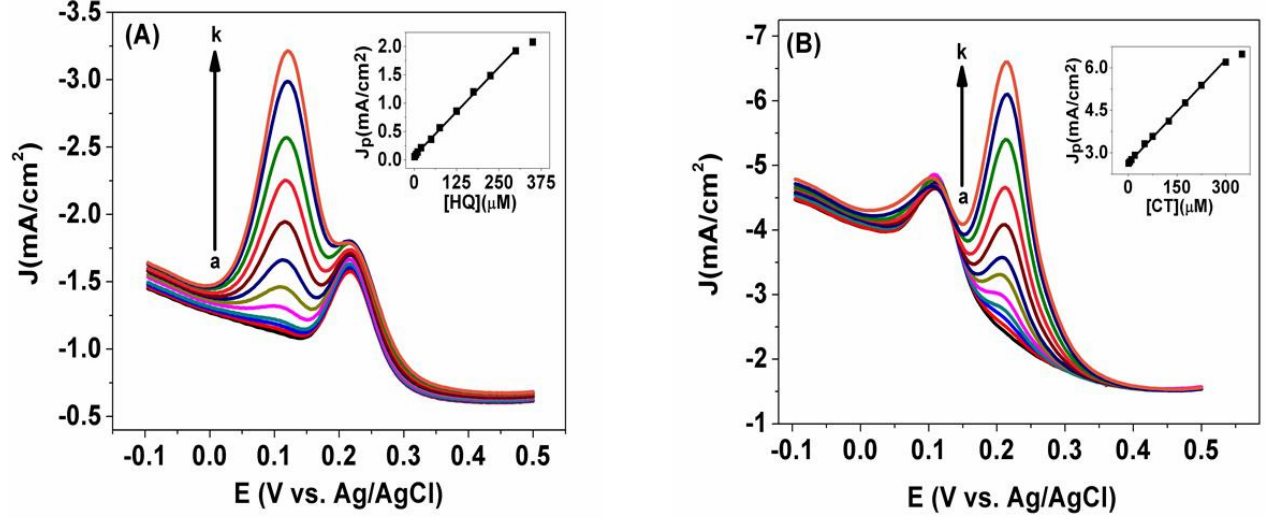
Figure 7. DPVs for PBCB2 in solution of different concentrations (a-k: 1, 5, 10, 20, 50, 75, 125, 175, 225, 300, and 350 µ M) of HQ containing 150 µ MCT ( A ) and different concentrations (a–k: 1, 5, 10, 20, 50, 75, 125, 175, 225, 300, and 350 µ M) of CT containing 150 µ M HQ ( B ). Insets show the calibration plots of HQ and CT.